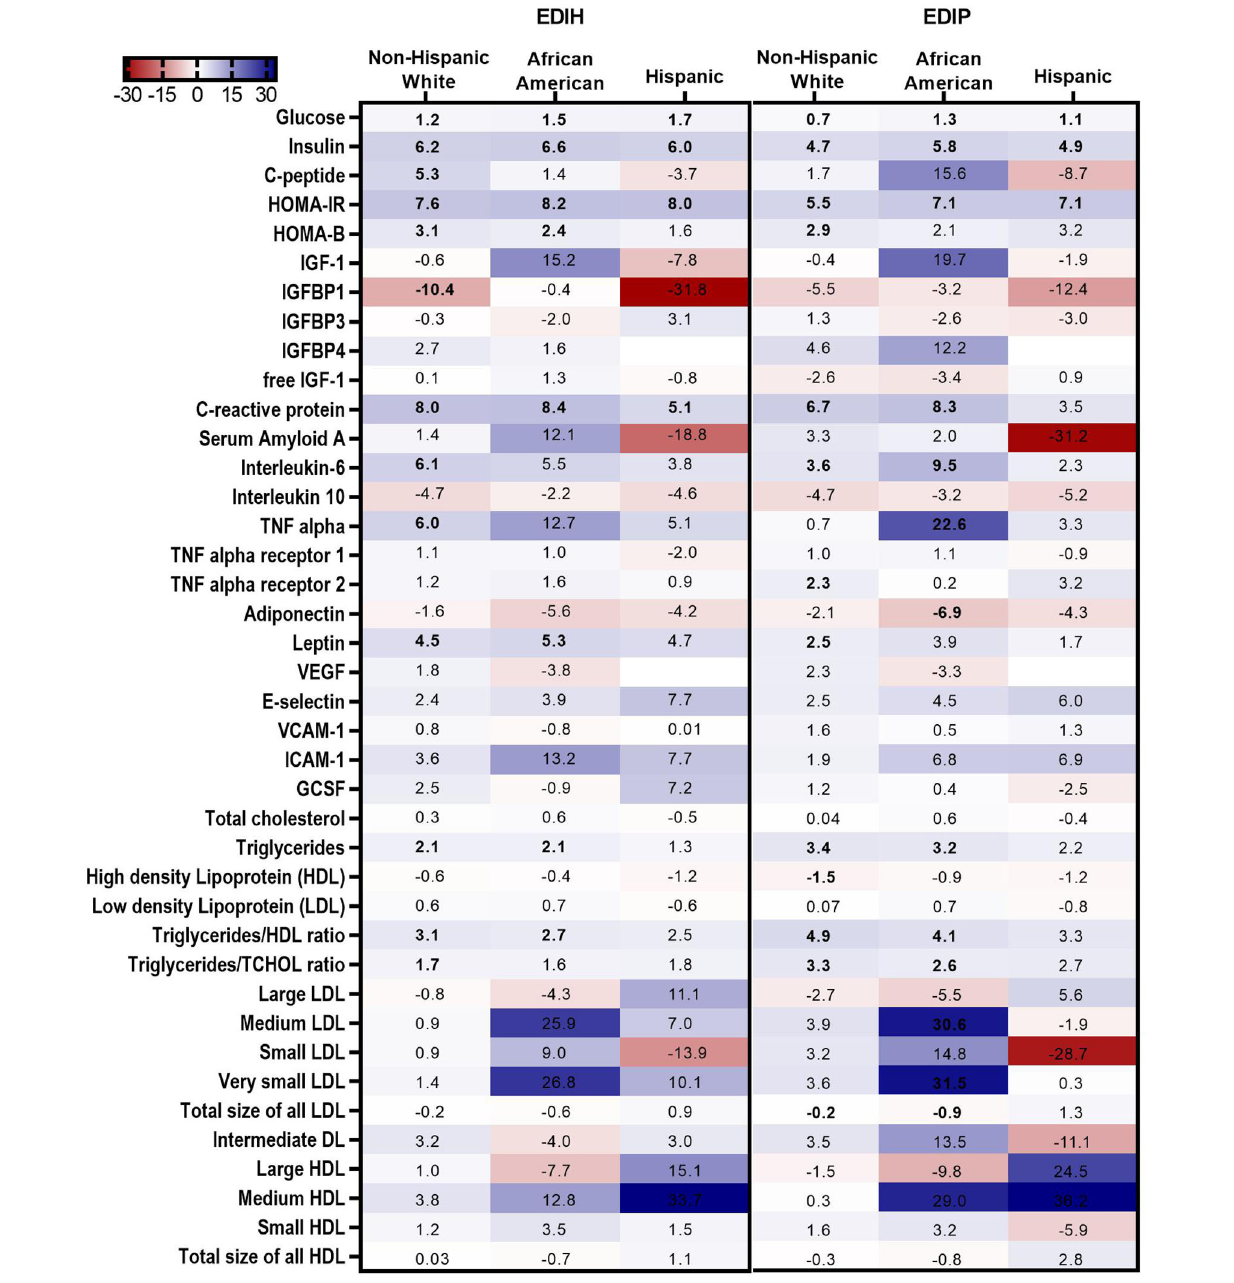
FIGURE 6 | Heat map showing the percentage difference (PD) in biomarker concentrations for each 1 standard deviation increment in the dietary index score in race/ethnic categories. Biomarker concentrations were log transformed using natural logs. Values (beta coefficients) presented were obtained via multivariable-adjusted linear regression models adjusted for the following variables: total energy intake, BMI-continuous, age, total recreational physical activity, pack years of smoking; number of supplements used; fasting status at blood draw, educational levels, regular use of NSAID, statins, unopposed estrogen and/or estrogen plus progesterone hormones, hormone therapy (HT) study arms. The color gradient ranges from red (inverse associations) to blue (positive associations). Values in bold font were statistically significant (FDR p < 0.10). Small sample sizes in race groups, such as Asian/Pacific Islander and American Indian/Alaskan Native, could not allow for subgroup